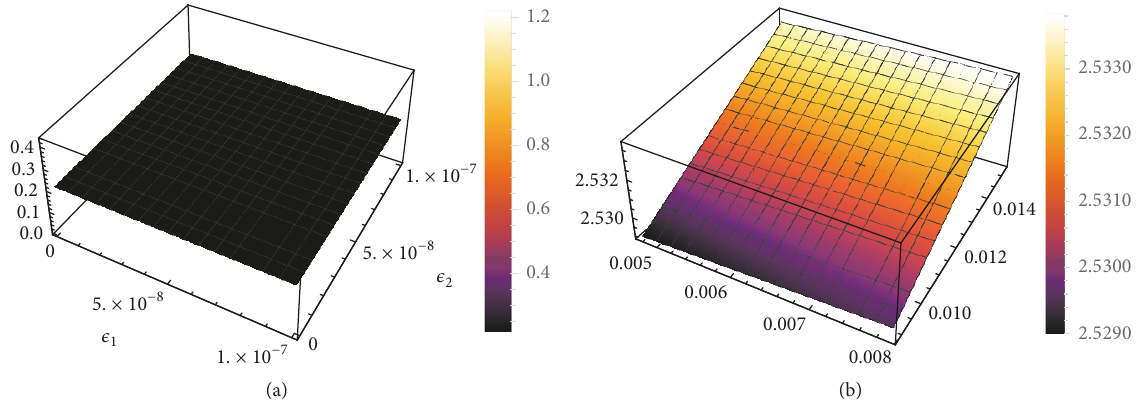
Figure 4: (a) The value of 𝑟 as a function of 𝜀 1 and 𝜀 2 from the effects of isospin symmetry for the decay process of 𝐵 𝑠 󳨀→ 𝜋 0 𝜂 . (b) The same as (a) from the effects of isospin symmetry breaking. The horizontal axis and vertical axis refer to the values of 𝜀 1 and 𝜀 2 ,